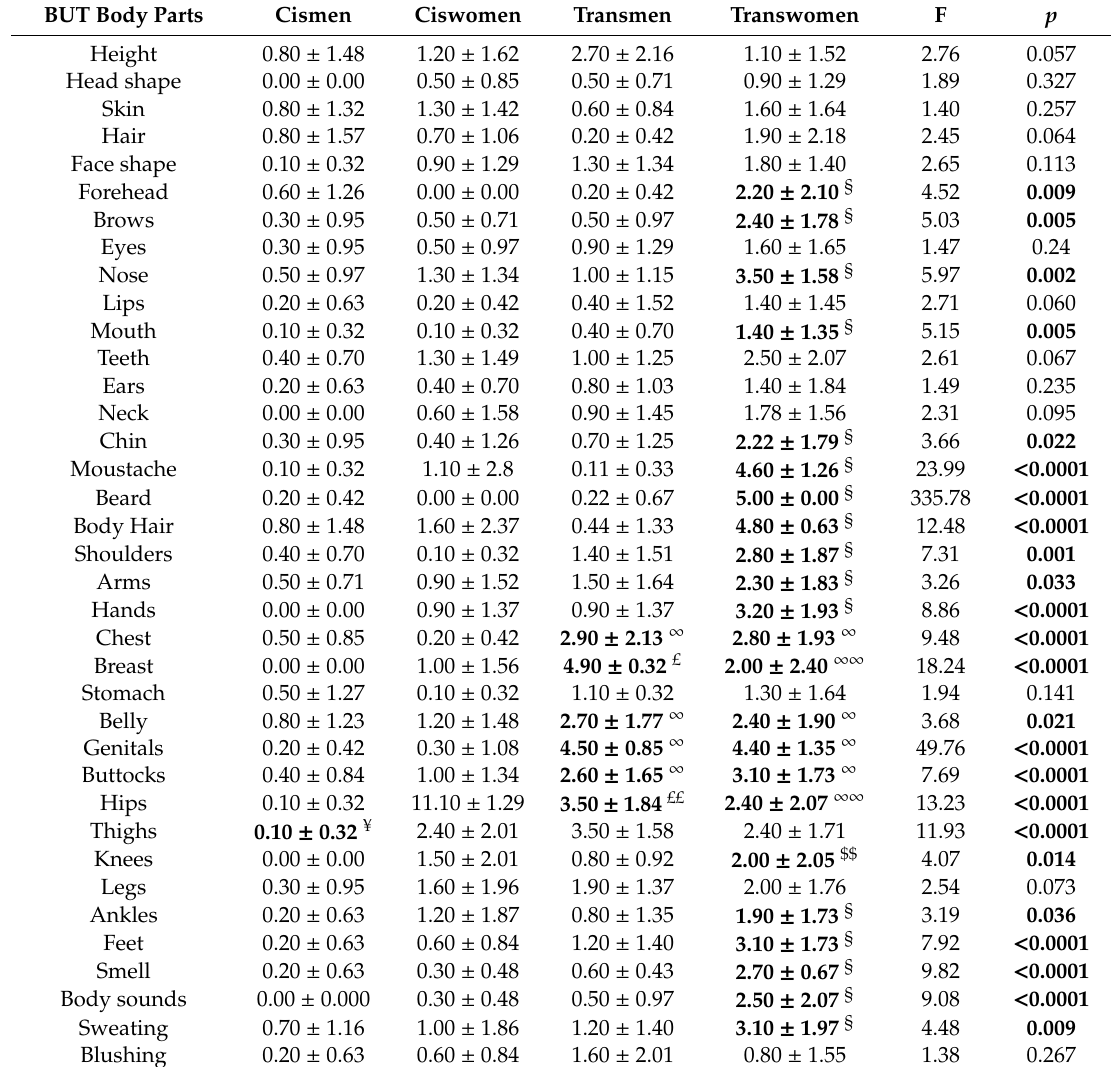
Table 5. Summary of means, standard deviations and statistical di ff erences in dislike of body parts (BUT-B) between male cismen, ciswomen, transmen and transwomen, as derived by ANCOVA and Post hoc Tukey’s B test after adjustment for age and